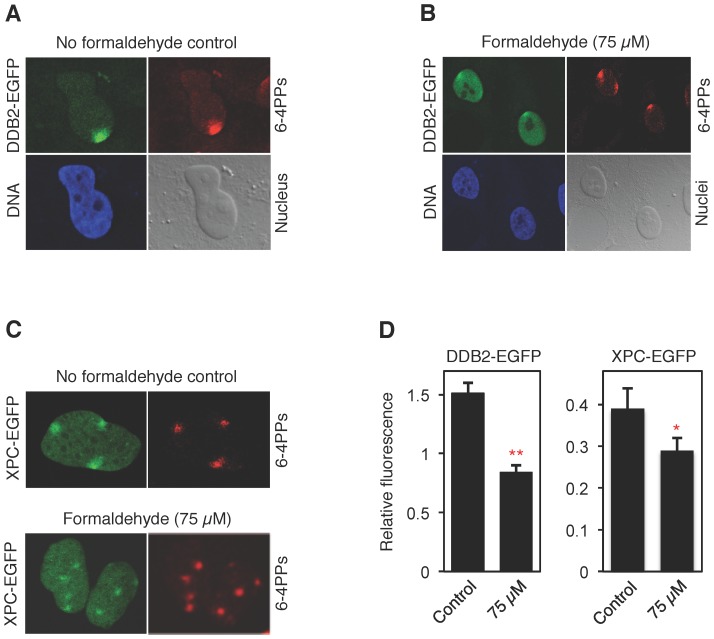
Accumulation of damage recognition factors on UV lesions.(A) Representative image illustrating the redistribution of DDB2 to UV lesion sites visualized with antibodies against (6-4) photoproducts. Human fibroblasts transfected with DDB2-EGFP were UV-irradiated through the pores of polycarbonate filters and fixed 15 min after treatment. DNA is evidenced by the Hoechst reagent and the nuclei are shown with contrast images. (B) Representative cells demonstrating the defective translocation of DDB2-EGFP from undamaged nuclear areas to UV lesions after 18-h incubations with 75 μM formaldehyde. (C) Representative images illustrating that the 75-μM formaldehyde treatment impedes the redistribution of XPC-EGFP to UV lesions. (D) Reduced fluorescence intensity at UV lesion spots over the surrounding background in cells exposed for 18 h to 75 μM formaldehyde (N = 54; error bars, S.D.; *p<0.05, **p<0.01).